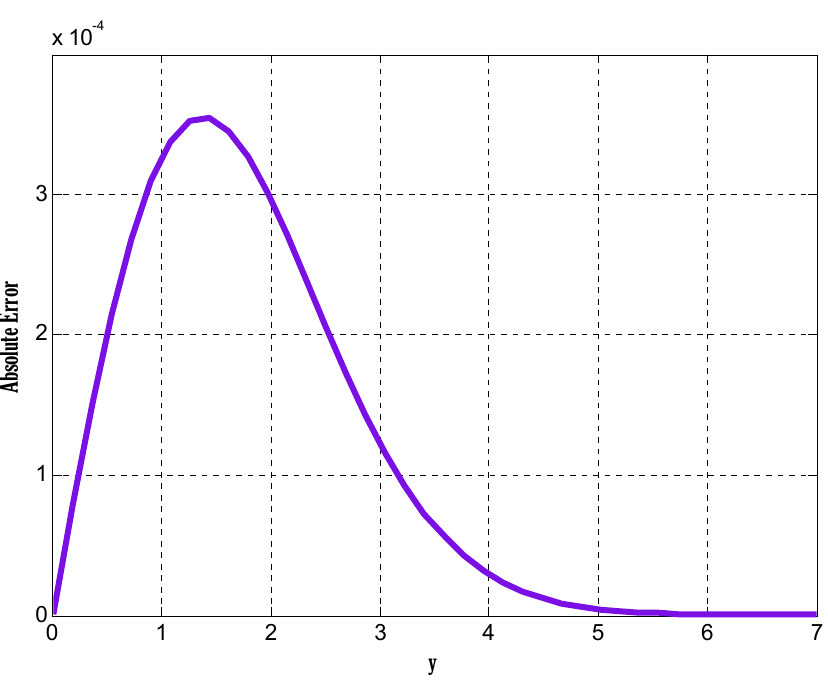
,𝑁 (cid:3047) = 350,𝑁 (cid:3052) = 40,𝑡 (cid:3033) = 1 . Figure 12. Absolute error obtained by the proposed scheme using a = 1 2 , N t = 350, N y = 40, t f = 1. (cid:2870)